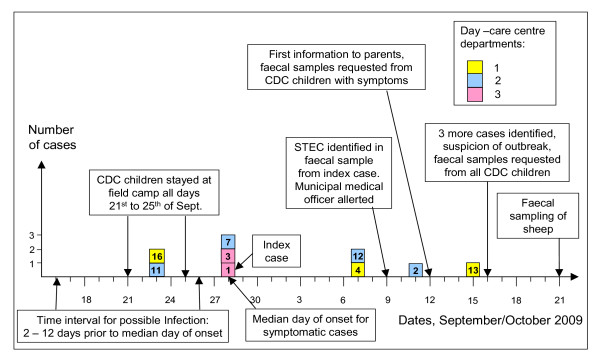
Epidemic curve of STEC O145 outbreak in child day-care centre Norway, 2009 with dates of onset for symptomatic cases (n = 9). Numbers in case boxes refer to case number as listed in Table 2.